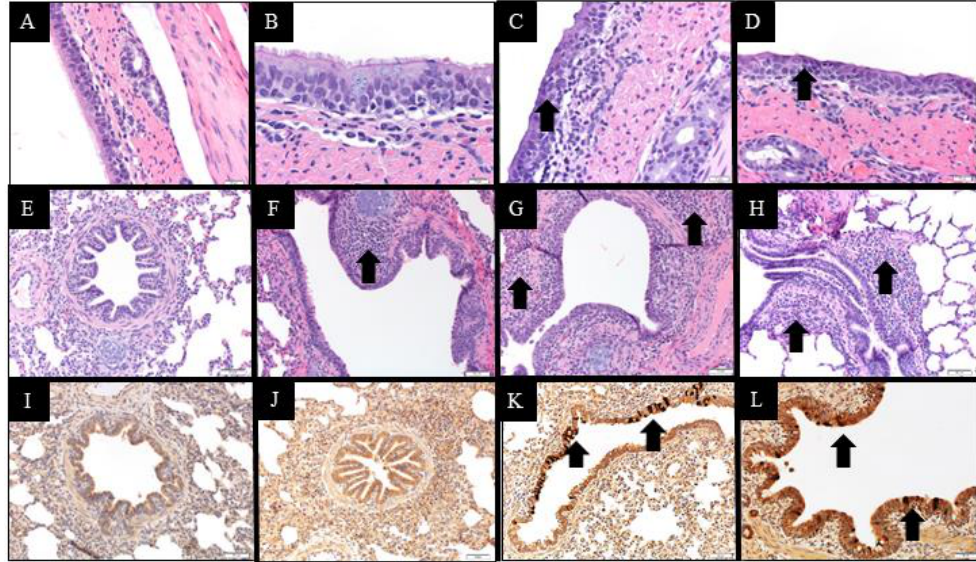
Figure 6. Microscopic lesions of the upper and lower respiratory tract in PPIV1 and HPIV1 challenged nursery pigs. Images A-D, E-H, and I-L correspond to H&E stain of the trachea (400 × ), H&E stain of the lung (200 × ), and IHC of the lung (200 × ), respectively. Images from the same column ( A – I , B – J , C – K and D – L ) correspond to Ctrl, HPIV1, IA17, and MN16 groups, respectively. Microscopic lesions were lacking or minimal in the trachea ( A , B ; score 0) and no PPIV1 signal was observed in the lung ( I , J ; score 0) of the Ctrl and HPIV1 groups, respectively. Lung lesions were also lacking in the Ctrl group ( E ; score 0). Mild to moderate epithelial attenuation and loss of cilia (black arrows) was observed in the IA17 ( C ; score 2.5) and MN16 ( D ; score 3.0) trachea. Mild to moderate peribronchiolar cuffing (black arrows) consisting of mononuclear cells were observed in the lung from HPIV1 ( F ; score 0.5), IA17 ( G ; score 5.0), and MN16 ( H ; score 2.5) groups. PPIV1 specific signal indicated as brown staining (black arrows) was observed in the bronchiolar epithelium in the IA17 ( K ; score 3.0) and MN16 ( L ; score 2.0) groups. PPIV-1 signal was also observed in the respiratory epithelium of the trachea and turbinate in the IA17 and MN16 groups (data not shown).